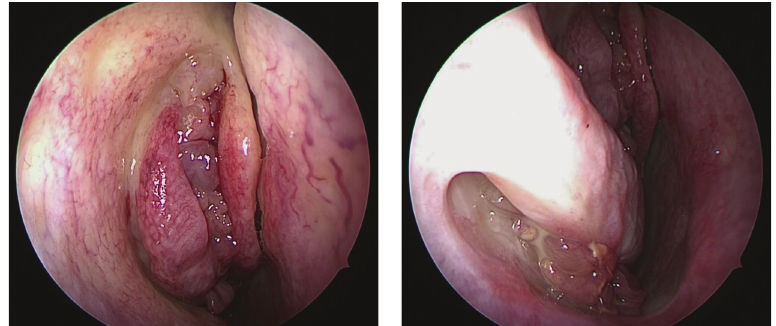
Figure 1: Preoperative observation of nasal cavity. Inverted papilloma is observed behind the uncinate process and inferior meatus.